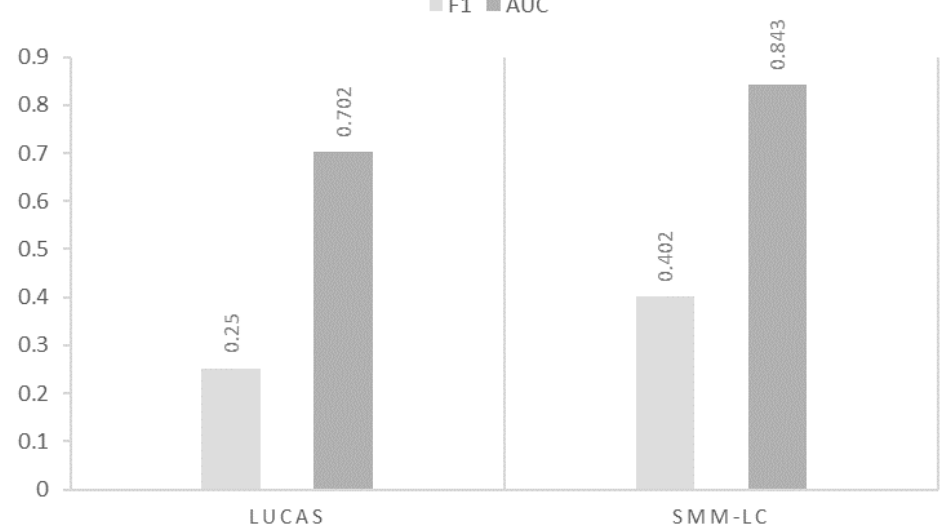
Figure 11. The SMM comparison against the LUCAS benchmark.